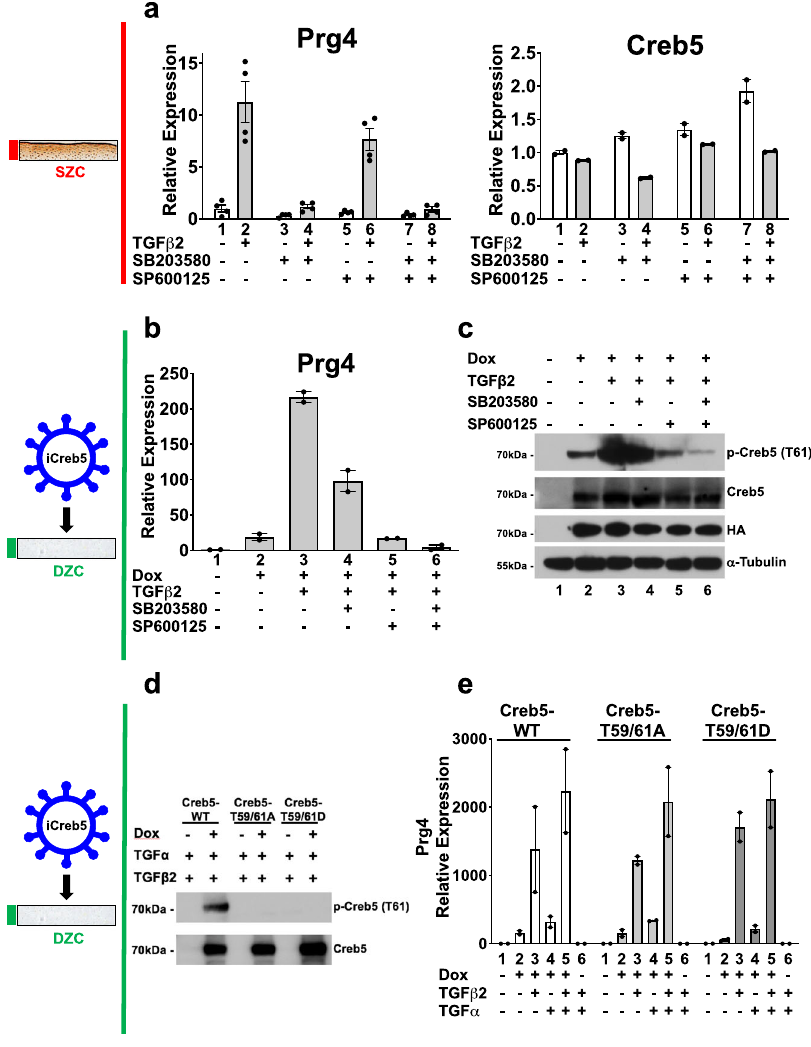
Fig. 5 Creb5-dependent induction of Prg4 requires SAPK activity, but neither phosphorylation of T59 nor T61 in Creb5. a TGF- β 2 induced expression of Prg4 in super fi cial zone articular chondrocytes is blocked by inhibition of p38 activity. SZCs were cultured in either the absence (white) or presence (gray) of TGF- β 2 (20 ng/ml), plus a p38 inhibitor (SB203580; 10 μ M), or a JNK inhibitor (SP600125; 10 μ M), as indicated for 2 days. Gene expression was assayed by RT-qPCR and normalized to Gapdh . Error bar indicates standard error of the mean ( n = 4 technical repeats for Prg4 expression, and n = 2 technical repeats for Creb5 expression). Similar results have been obtained in three independent biological repeats. b , c DZCs were infected with a lentivirus encoding doxycycline-inducible Creb5-HA. After selection in G418, the cells (iCreb5-DZCs) were cultured in either the absence or presence of doxycycline (1 μ g/ml), TGF- β 2 (20 ng/ml), a p38 inhibitor (SB203580; 10 μ M), or a JNK inhibitor (SP600125; 10 μ M), as indicated for 2 days. b